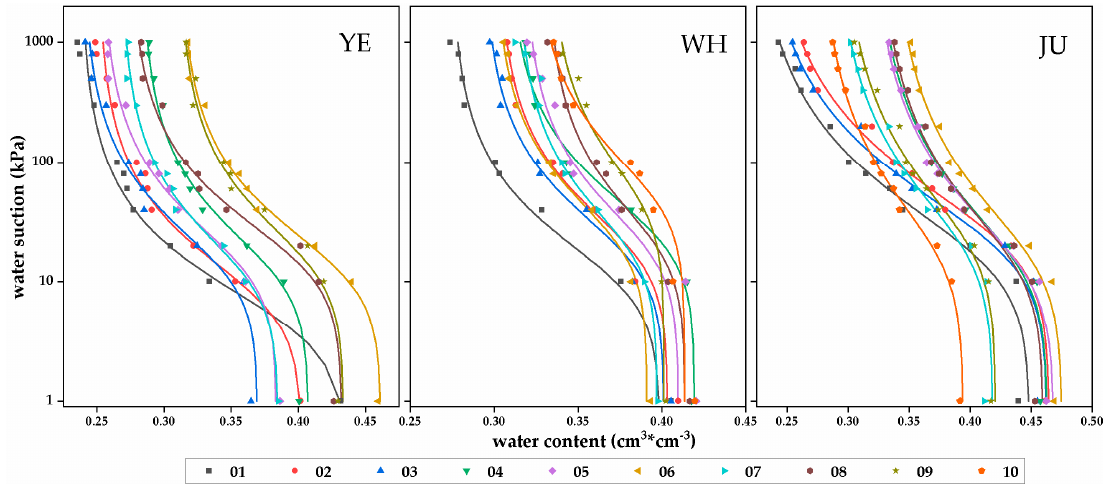
Figure 11. Soil water retention curves (SWRCs) of the YE, WH, and JU profiles. In this figure, the colored dots represent the measured data, and the lines represent the fitted curve using the van Genuchten ( m = 1 − 1 / n ) model. At the bottom of this figure, a series of colored points numbered from 01 to 10 represents the sampled soil layers from 1–10 cm to 90–100 cm (only 9 layers in the YE